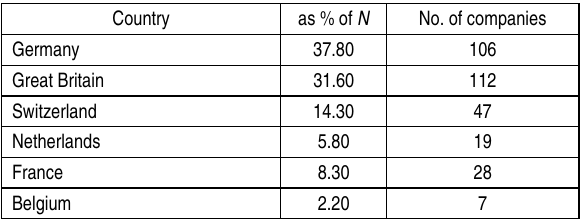
Table 1. Distribution of companies in relation to